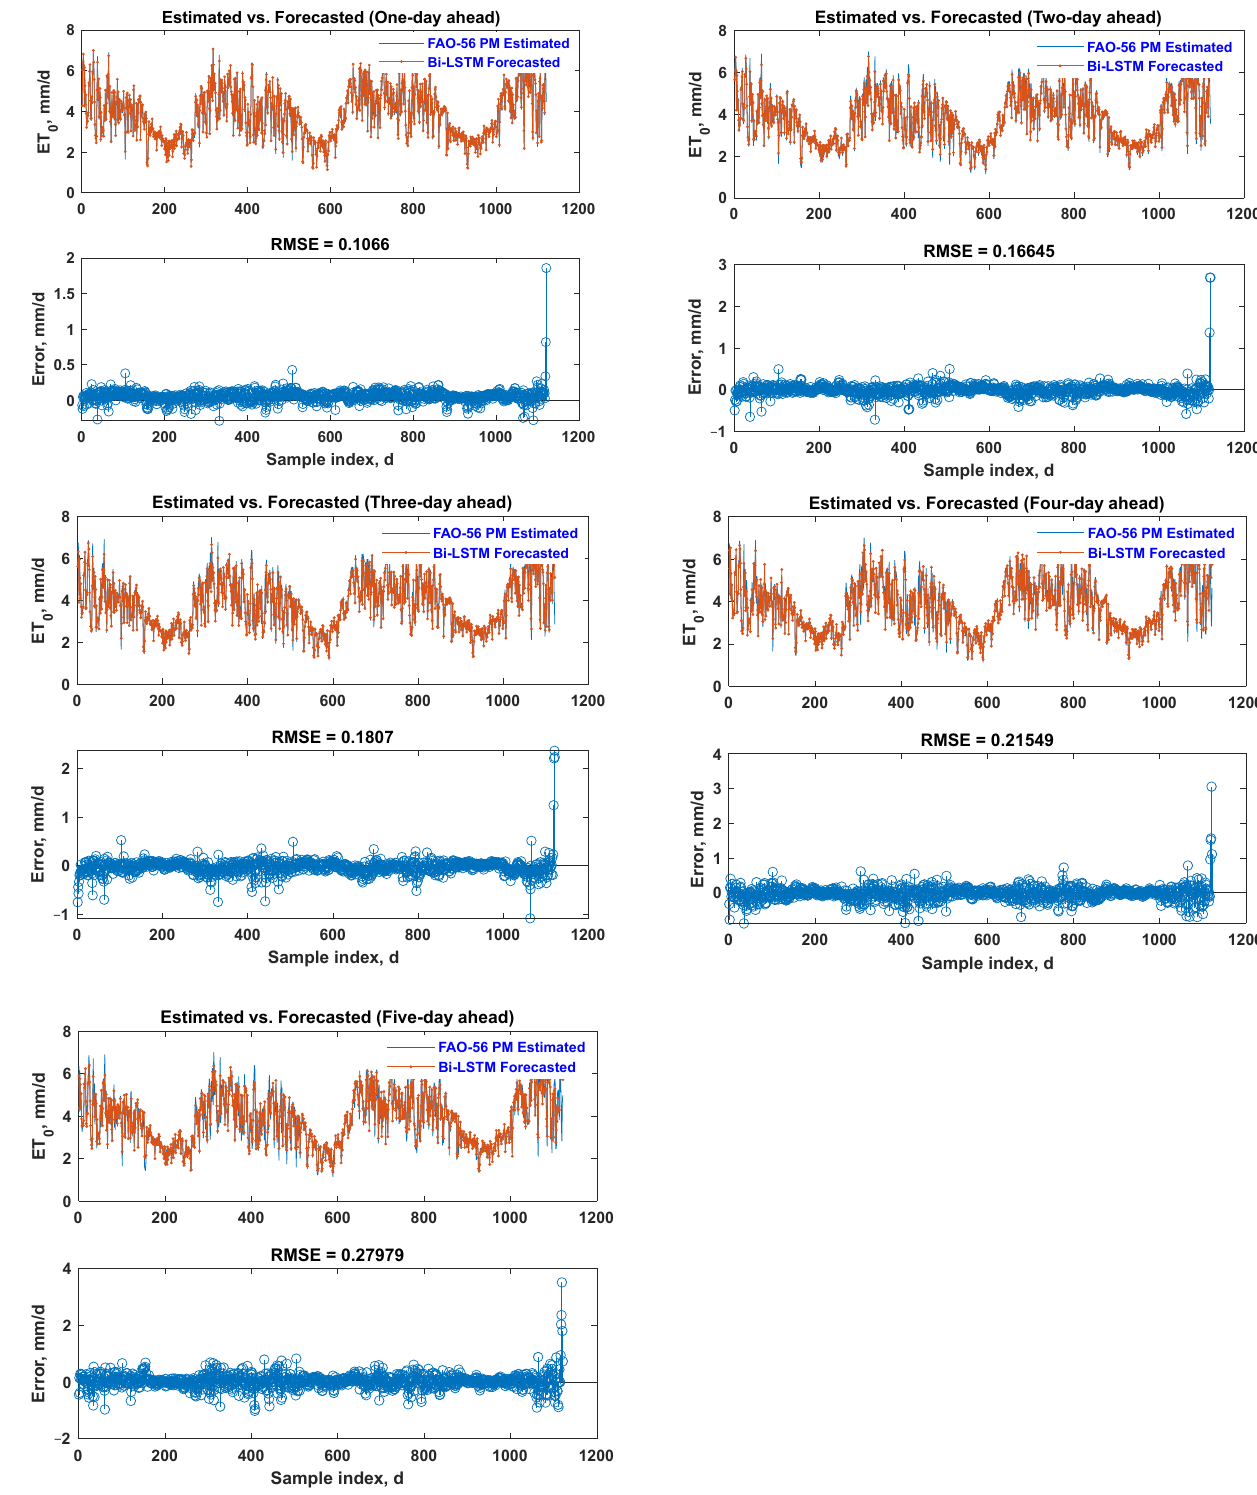
Figure 10. Line graph and error plots for 1, 2, 3, 4, and 5 day-ahead forecasting at Gazipur station.